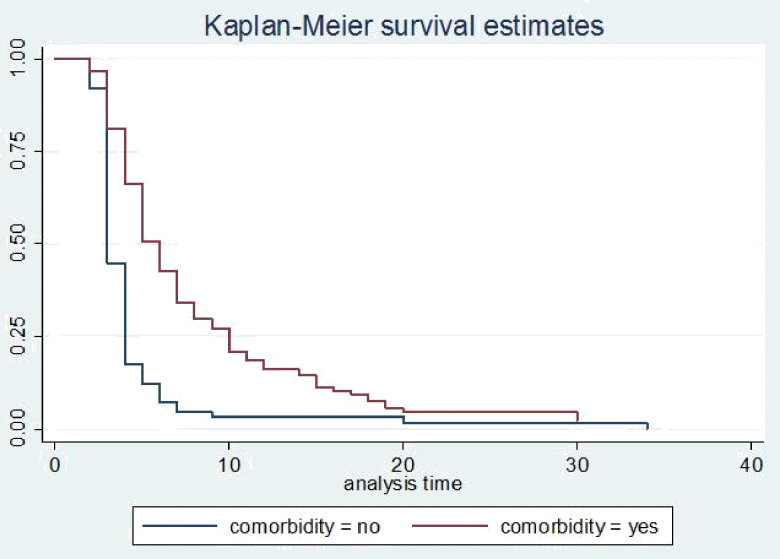
Kaplan-Meier survival estimate for time to recovery among SCAP children with comorbidity.